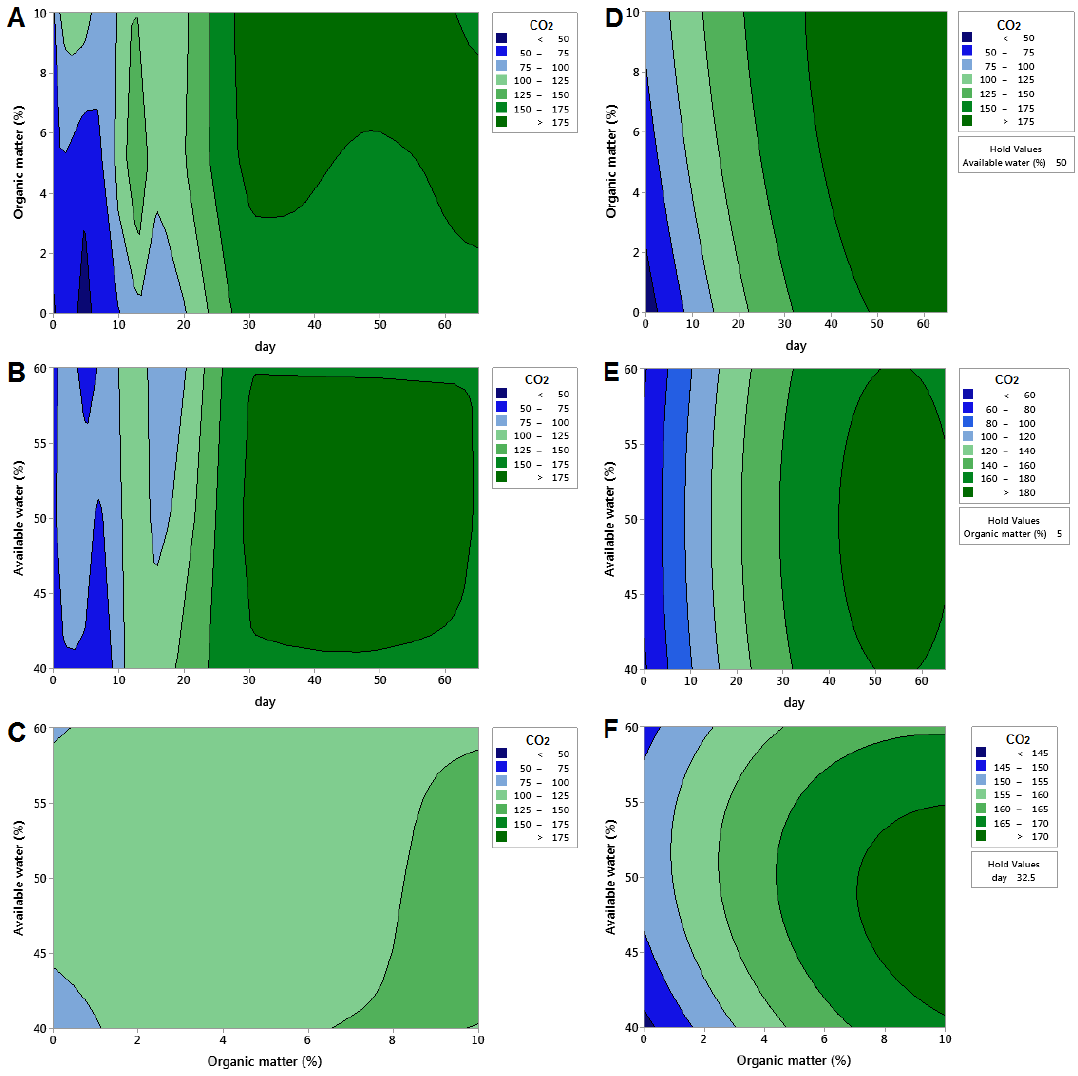
Figure 2. (A and D) (B Contour plotting for CO 2 emissions in calcareous saline soil under different organic matter inputs a nd E) (C a nd F) ( A, B , and C) and during the incubation period ; different water availability and during the incubation period (D, E, and F) ; and different organic material and water availability inputs . represent raw data contour plotting while represent response surface contour